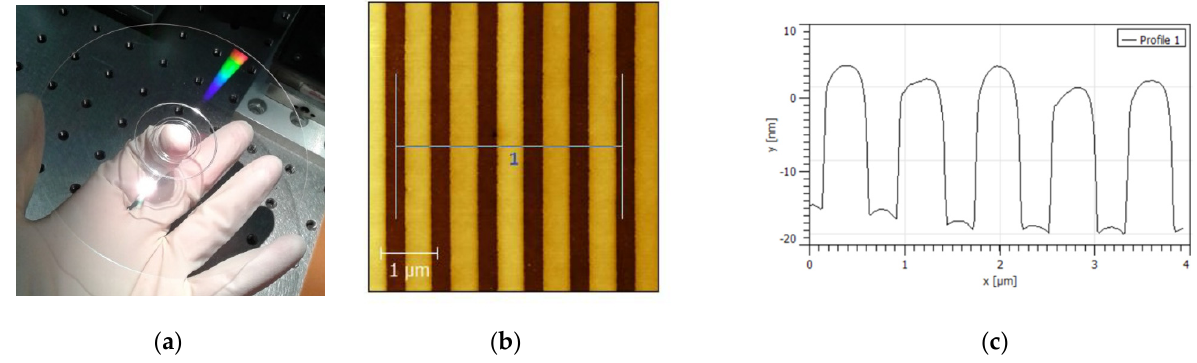
Figure 1. ( a ) Photograph of the DVD used as a diffraction grating for refractometric measurements. ( b ) AFM image and ( c ) profile of the surface DVD grating.